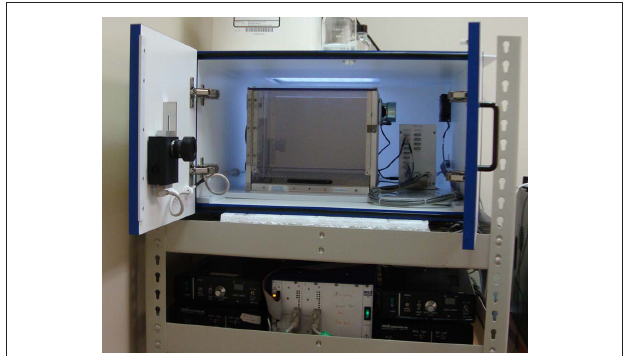
Figure 5 | Fear conditioning is a form of associative learning in which a previously neutral conditioned stimulus (CS), such as a tone, is paired with an aversive unconditioned stimulus (uS), usually a foot shock. Through this pairing, the CS comes to elicit responses characteristically associated with the